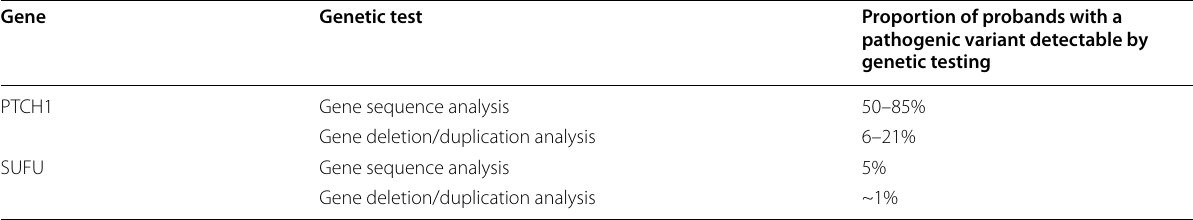
Table 1 Molecular genetic tests used in Gorlin-Goltz syndrome Gene Genetic test Proportion of probands with a